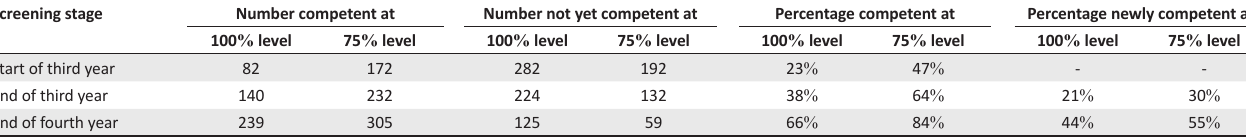
TABLE 2 : Number and percentage of students competent over time ( N = 364).